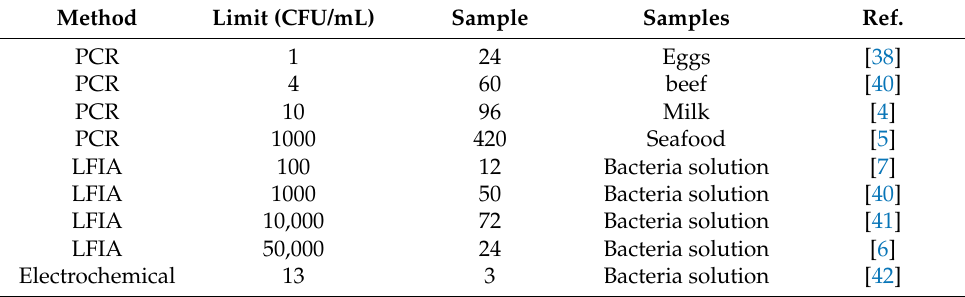
Table 3. Comparison of different methods in literature for Salmonella